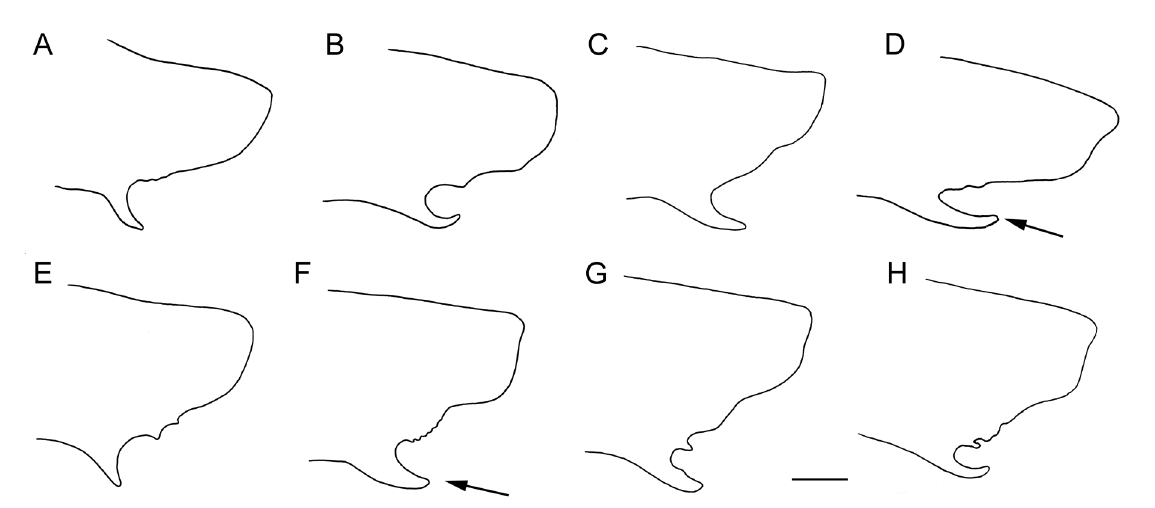
Fig. 21. Apical part of male metafemur, lateral view. A–D . Merodon bombiformis Hull, 1944 A . Specimen FSUNS ( FSUNS ID ZA2_079). B . Specimen NMSA (FSUNS ID 04276). C . Specimen NMSA (FSUNS ID 04277). D . Specimen NBCN LML-05-5 (FSUNS ID 04282). E . M. vittatus Vujić & Likov sp. nov., holotype (NBCN; FSUNS ID 04085). F–G . M. multifasciatus Curran, 1939. F . Specimen NMSA (FSUNS ID 04284). G . Specimen NBCN LML-05-3 (FSUNS ID 03909). H . M. apimina Hull, 1944, paratype (NBCN; FSUNS ID 04086). D, F . Distinct apical dent on triangular process marked with arrow. Scale bar = 1 mm.